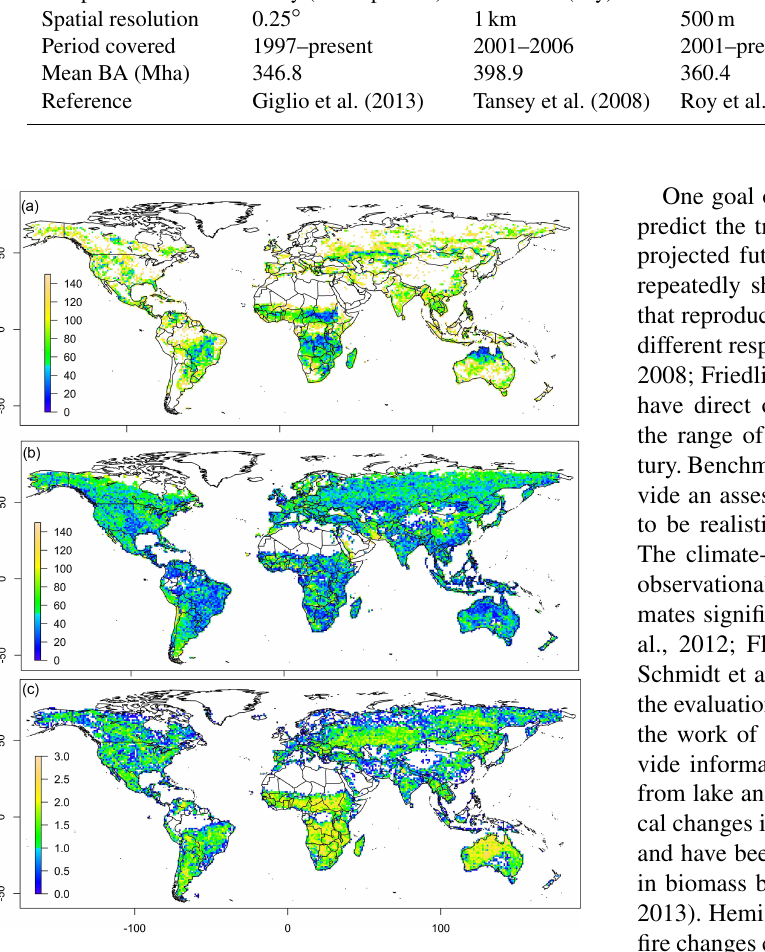
Figure 3. Coefficient of variation (%) characterizing (a) inter- product variability in mean burnt area; (b) the inter-product vari- ability of the interannual variability in burnt area; and (c) the inter- product variability of the slope of temporal trends (2001–2007). Plots (a) and (b) are based on all four burnt-area products (GFED4, MCD45, L3JRC, Fire_cci) whereas plot (c) is based on three prod- ucts and does not include the MERIS data because it is currently only available for 3 years, see Table